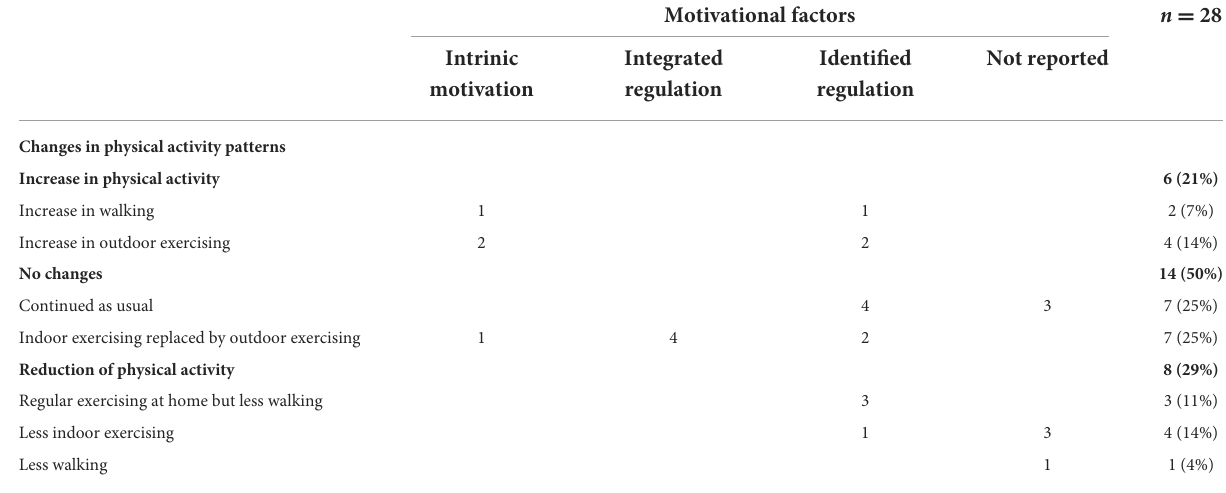
TABLE 5 Changes in physical activity and motivational